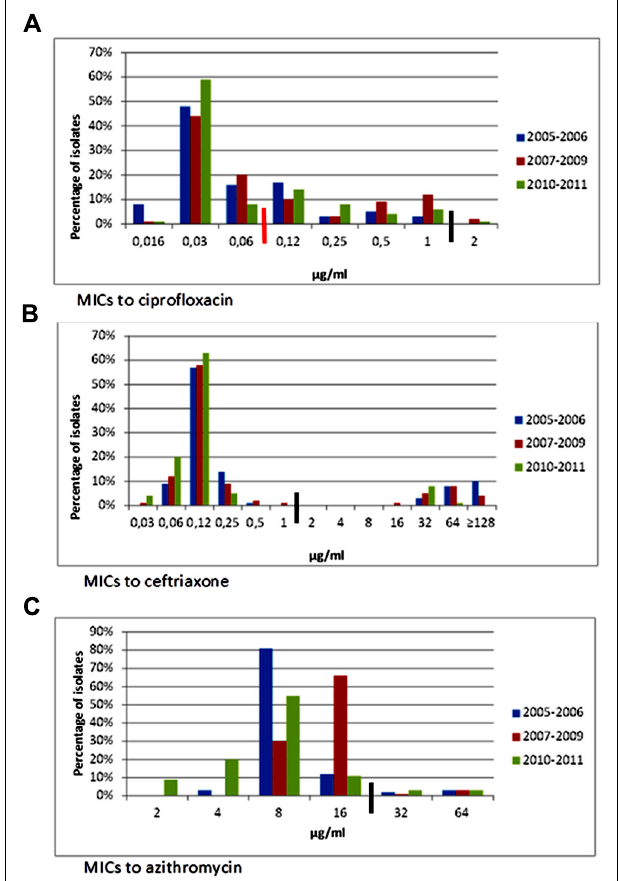
FIGURE 2 | Minimum inhibitory concentrations to ciprofloxacin, ceftriaxone, and azithromycin in Salmonella isolates from ill children at a state referral hospital inYucatan, Mexico, 2005–2011. Thick black lines indicate breakpoints for resistance. Number of isolates for each period was as follows: 2005–2006, n = 147; 2007–2009, n = 138, and 2010–2011, n = 80. (A) Ciprofloxacin MICs. Reduced susceptibility to ciprofloxacin in Salmonella rose from 28% in 2005–2006 to 33% in 2010–2011. Non-susceptibility (MIC = 2) first emerged in 2007 in a S . Anatum isolate and later appeared in S . Typhimurium multidrug-resistant, cephalosporin-resistant isolates. Black line is resistance breakpoint for isolates from stools; red line is breakpoint for systemic infections. CLSI breakpoints for susceptibility and resistance in isolates from stools are 1 and 4 μ g/ml, respectively. Breakpoints for susceptibility and resistance in isolates from systemic infections are 0.06 and 1 μ g/ml, respectively. (B) Ceftriaxone MICs. Resistance to ceftriaxone and other extended- spectrum cephalosporins significantly decreased from 19.7% during 2005–2006 to 8.8% in 2010–2011. Salmonella isolates were distributed into two distinct populations, one which was susceptible and the other resistant to ceftriaxone. CLSI breakpoints for susceptibility and resistance are 1 and 4 μ g/ml, respectively. (C) Azithromycin MICs. No significant changes in azithromycin MICs were noted. Suggested breakpoints for susceptibility and resistance are 16 and 64 μ g/ml, respectively (Sjolund-Karlsson etal.,